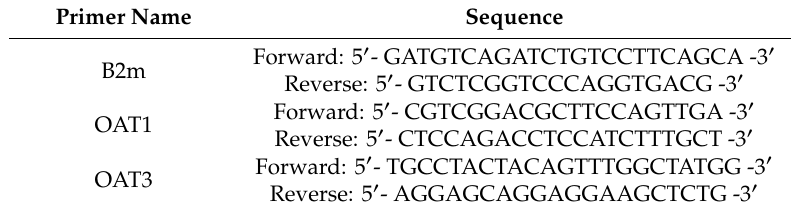
Table 3. Primer nucleotide sequences used in the qRT-PCR examination of gene